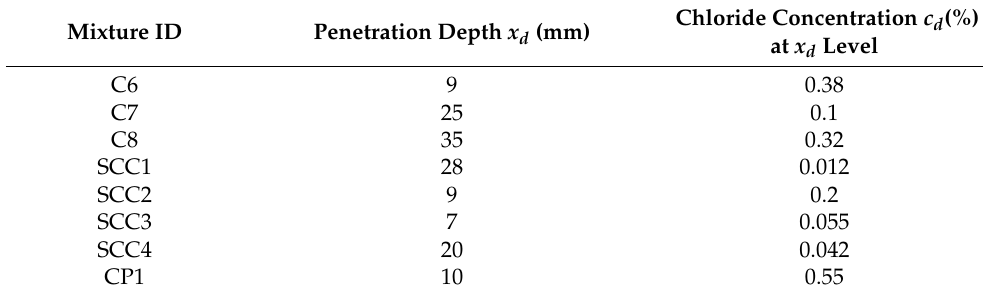
Table 7. Comparison of chloride concentration c d related to chloride penetration depth x d according to NT BUILD 492